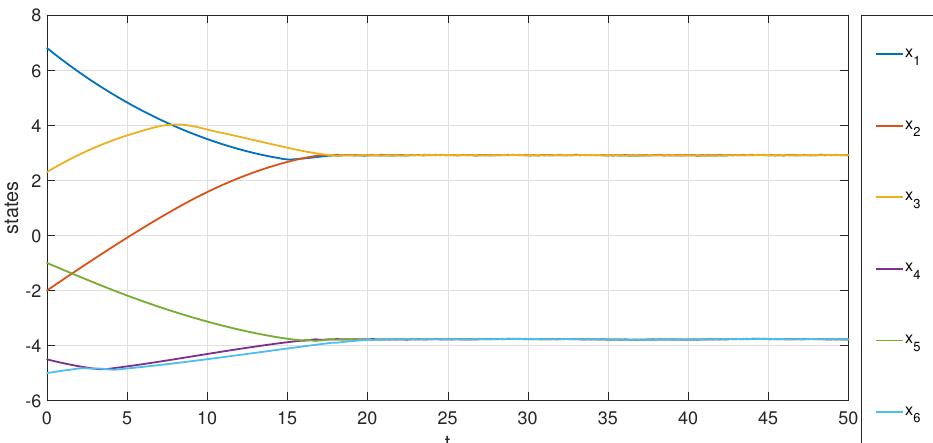
Figure 11. Simulation results relating to the topology in Figure 8.